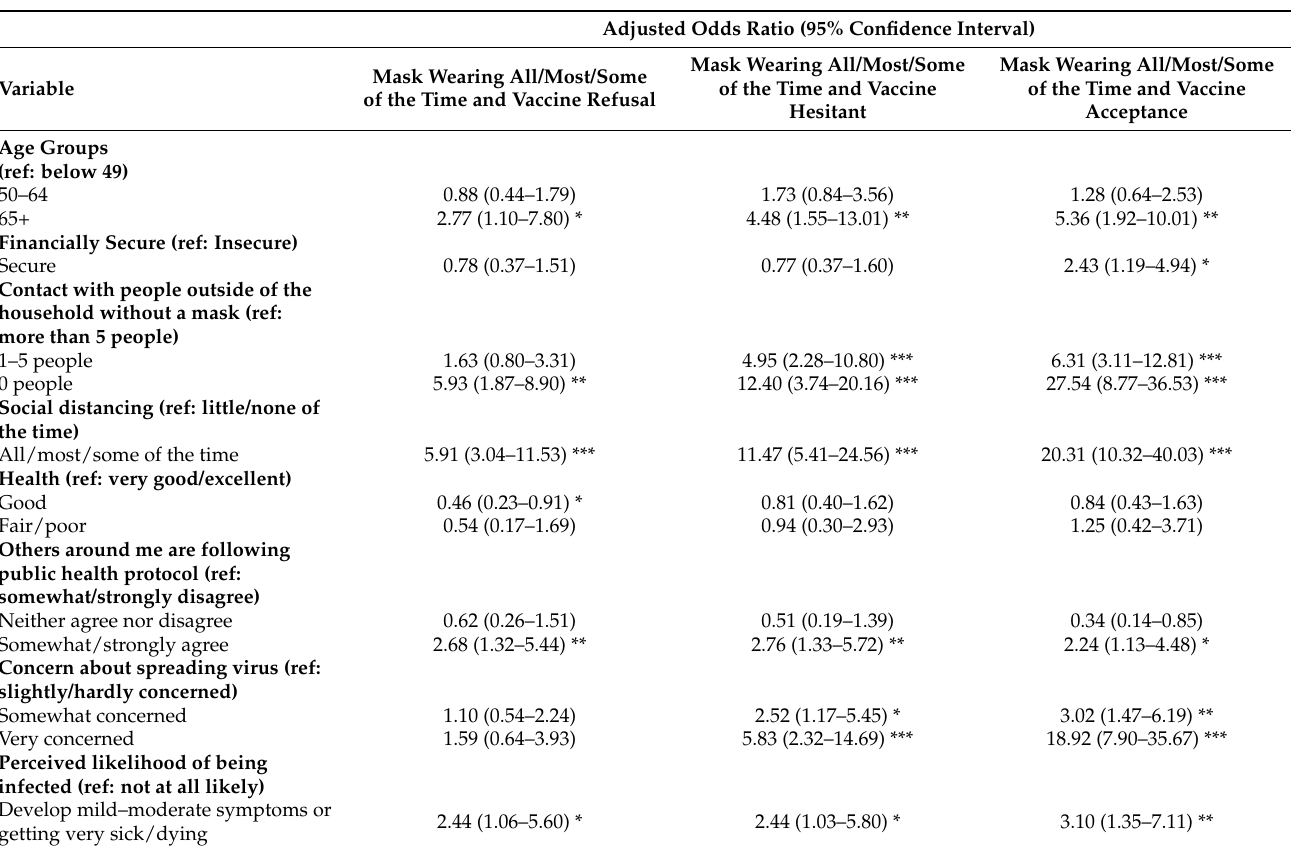
Table 2. Adjusted odds ratios for the dual behavior of mask wearing and vaccine intent by correlates ( n =